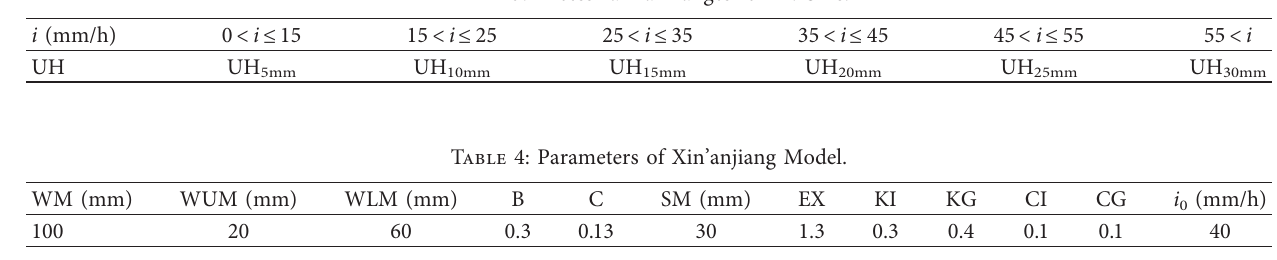
Figure 1: Map of the study basin with (a) basin location, (b) DEM and rainfall gauges, and (c) subbasins. Table 3: Excess rainfall ranges for TVUHs.